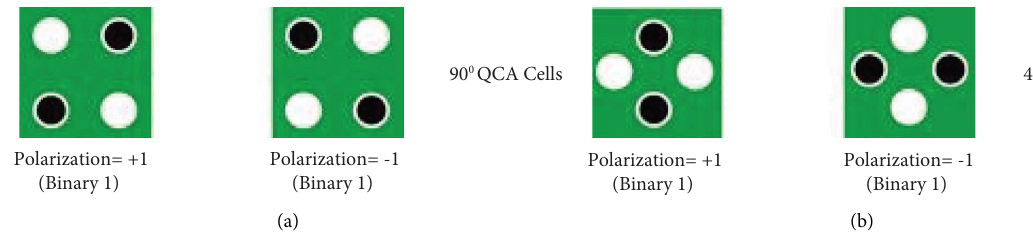
Figure 2: Basic QCA cells. (a) Null cell. (b) QCA cell with polarization � 1.